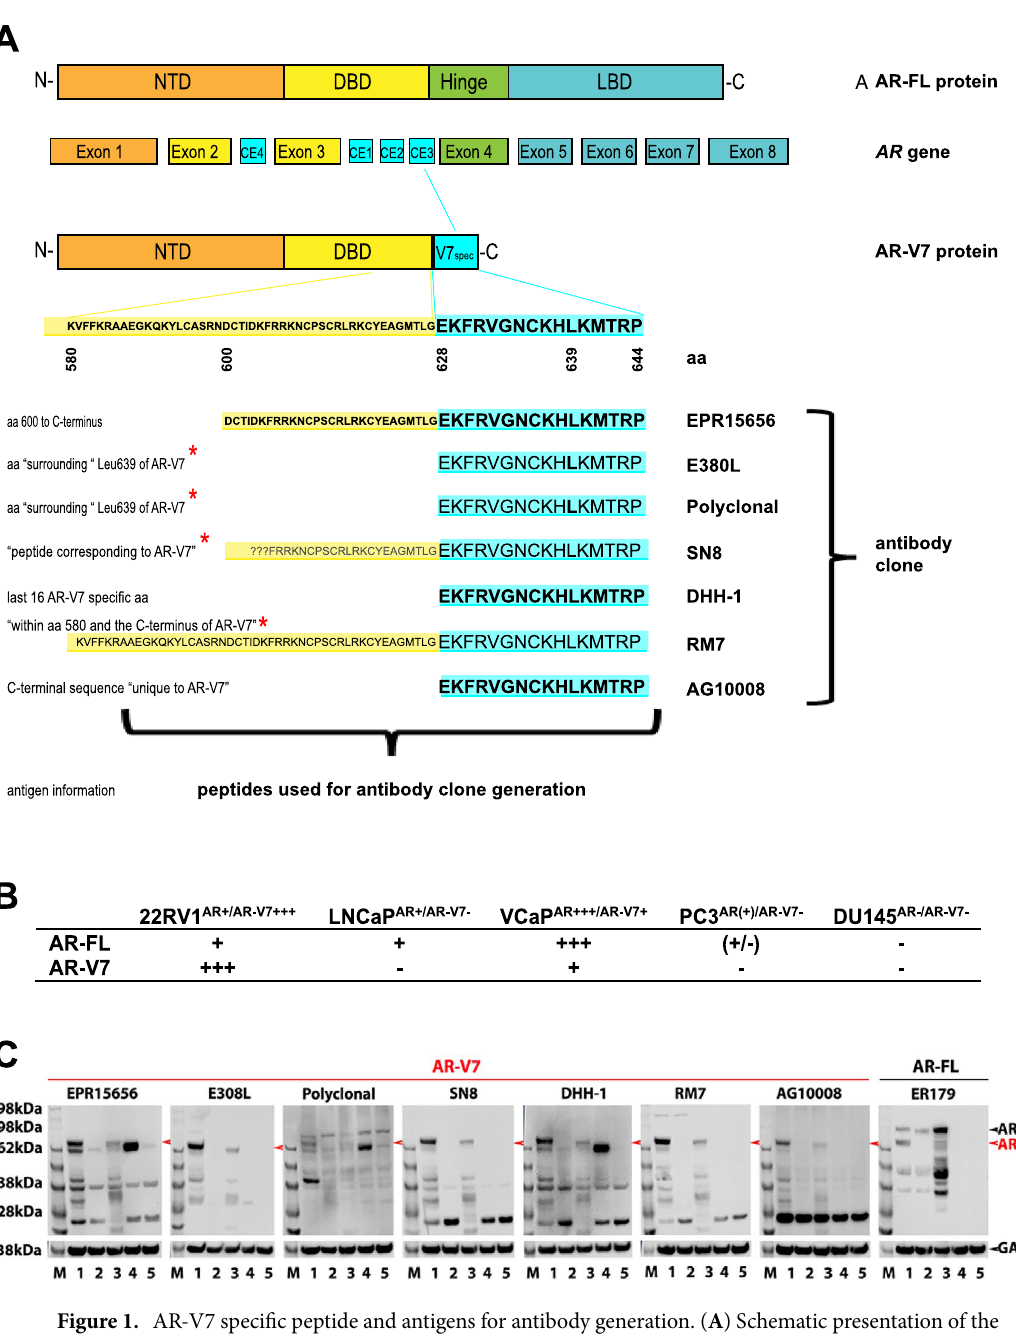
Figure 1. AR-V7 specific peptide and antigens for antibody generation. ( A ) Schematic presentation of the AR -gene encoding full length androgen receptor (AR-FL) and androgen receptor variant 7 (AR-V7) proteins. Amino acid (aa) sequences of cryptic exon (CE) 3 encoded AR-V7 specific domain (V7spec) and a section of DNA binding domain (DBD) shared with AR-FL are displayed and aa sequences representing antigens for antibody generation is indicated for the clones. Antigen information: as published by supplier or provided on request (*: information is considered ambivalent for four peptides, consequently shown aa sequences may not reflect exact antigen peptides, but are based on “informed assumption” that the V7 specific unique 16 aa are part of all peptides and uncertain proportions of the DBD shared with AR-FL as indicated); ???: DBD aa sequences uncertain; NTD: N-terminal domain; LBD: ligand binding domain; N-: N-terminal; -C: C-terminal. ( B ) Validation of AR-FL and AR-V7 mRNA expression in the indicated cell lines by ddPCR. – no detection; (+/−) low, but detectable; + detection; +++ high levels of AR-V7 or AR-FL copies; ( C ) Immunoblotting of total protein lysates from the indicated cell lines for AR-V7 (separate gels for each antibody, left), or AR-FL (right) using the indicated antibodies in reference to GAPDH (cropped from probing of the same membrane shown below each plot). M: size marker, 1: 22RV1 AR+/AR−V7+++ , 2: LNCaP AR+/AR−V7− , 3: VCaP AR+++/AR−V7+ , 4: PC3 AR(+/−)/AR−V7− , 5: DU145 AR−/AR−V7−